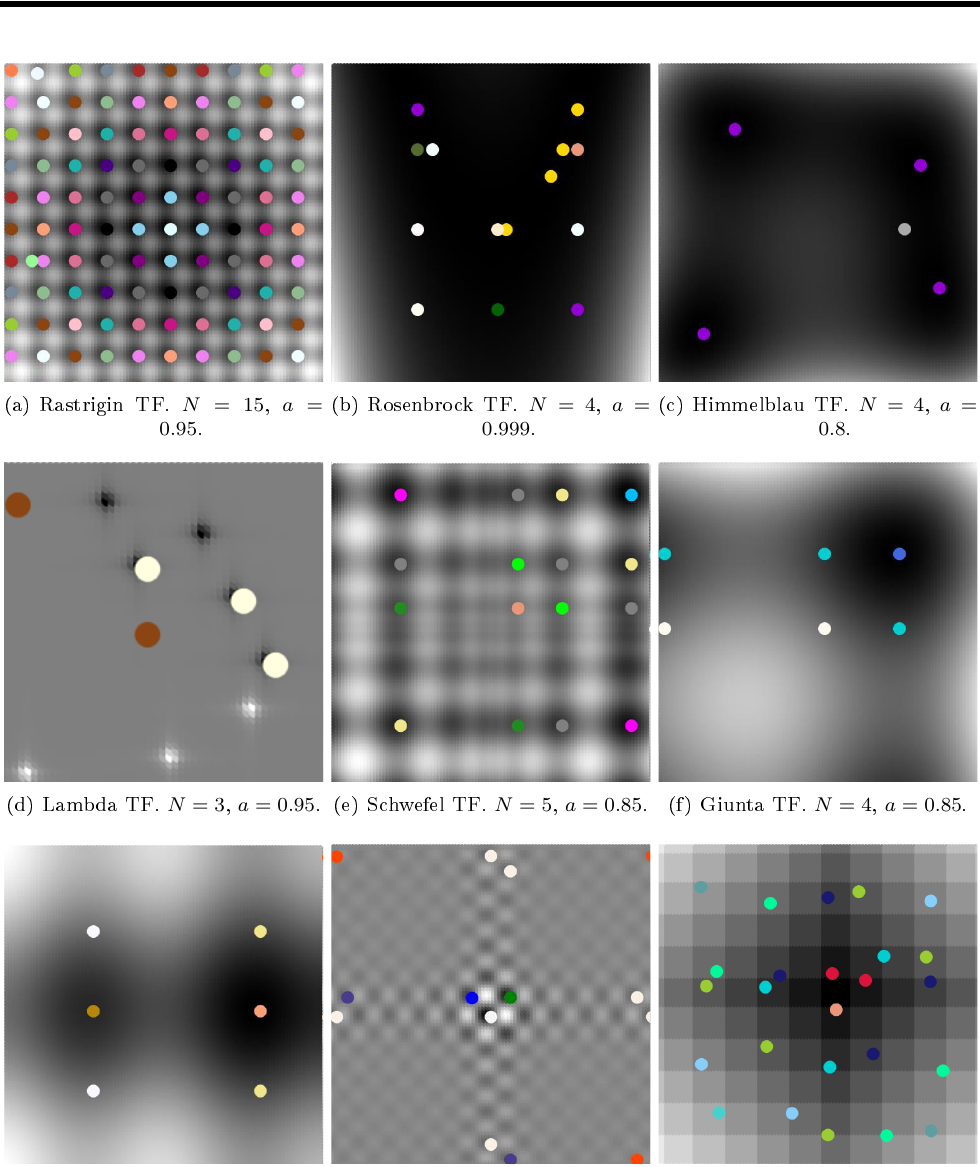
Fig. 8. Ursem TF. N =4, a =0.85. Fig. 9. Shubert TF. N =4, a =0.95. Fig. 10. Plateau TF. N =5, a =0.95. (g) Ursem TF. N = 4 , a = 0 . 85 . Fig. 2: ME SOMA modi(cid:28)caton results for di(cid:27)erent TF.